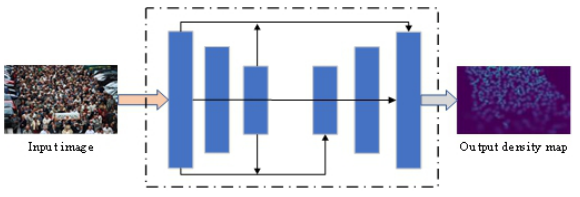
Fig. 3. Feature fusion process